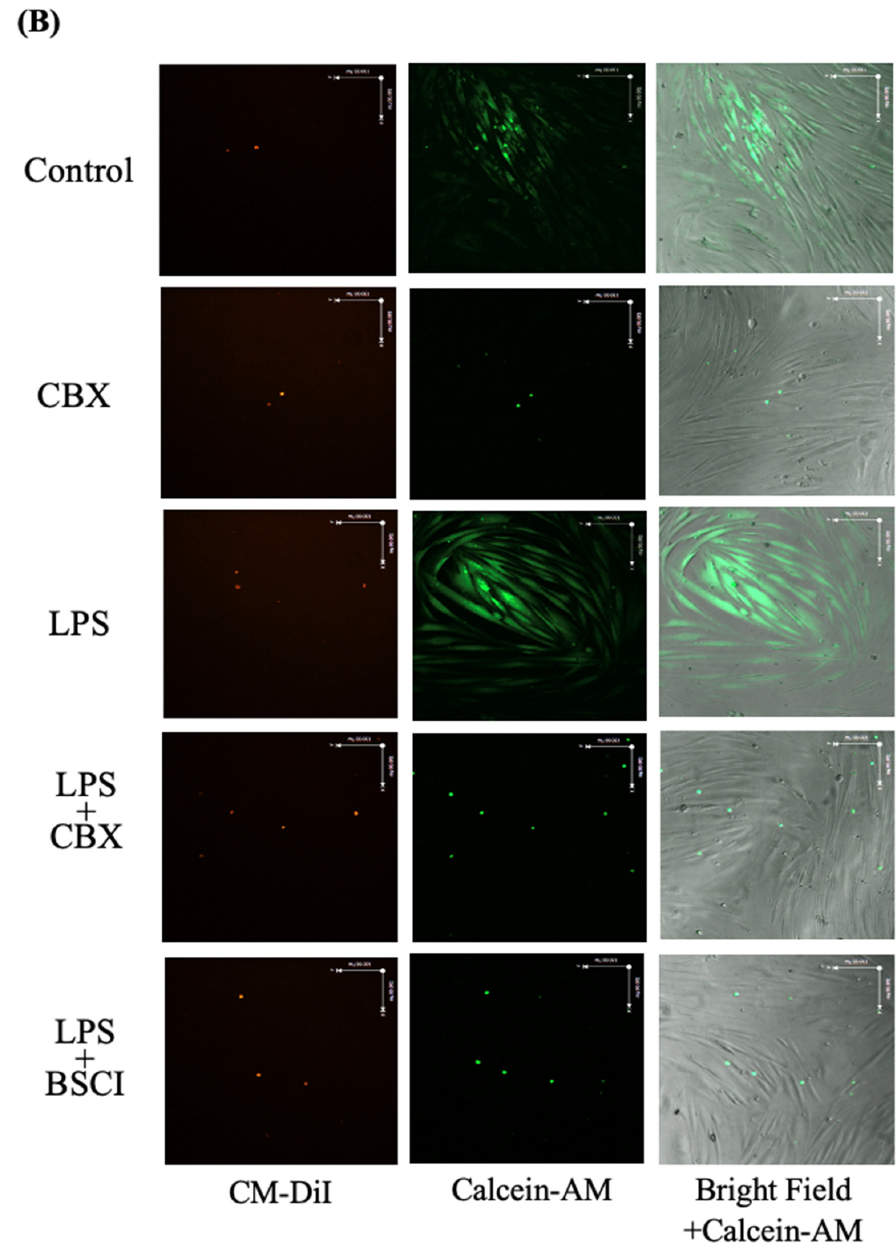
Figure 8. CX43 mediated GJIC between maternal macrophages and myocytes. ( A ) Representative immunofluorescence images of human myometrial cells co-cultured with blood-derived macrophages. Co-cultures were incubated overnight, fixed and immunostained with antibodies against CD68 (red stain, Alexa Fluor 594), CX43 (green stain, Alexa Fluor 488), and nuclear stain (blue, DAPI). ( B ) Macrophage–myocyte ‘parachute’ assay. Human myocytes (‘acceptor’ cells) were grown till 80% confluency and ‘donor’ macrophages were loaded with permeable Calcein-AM dye (green, 10 ug/mL) and non-transferable cell tracker CM-DiI (red, 5 μ g/mL). The ratio of donor to acceptor cells was 1:100. Representative images show ‘donor’ cells loaded with red CM-DiL. Transfer of green Calcein dye from ‘donor’ to ‘acceptor’ cells after 24 h of incubation with/out LPS (100 ng/mL), carbenoxolone (CBX, 150 nM), and FX125L (250 nM) is apparent in Control and LPS-treated myocytes, the transfer is blocked by CBX and BSCI. All images were taken on a DMI spinning disc confocal microscope (Leica, Wetzlar, HE, Germany). Scale bar = 100 μ m. Shown are images at 200× g magnification.